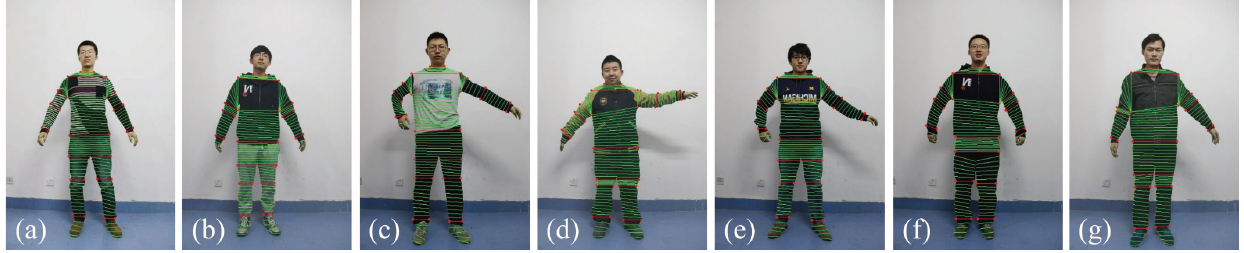
Fig. 8 Matching results for our system.